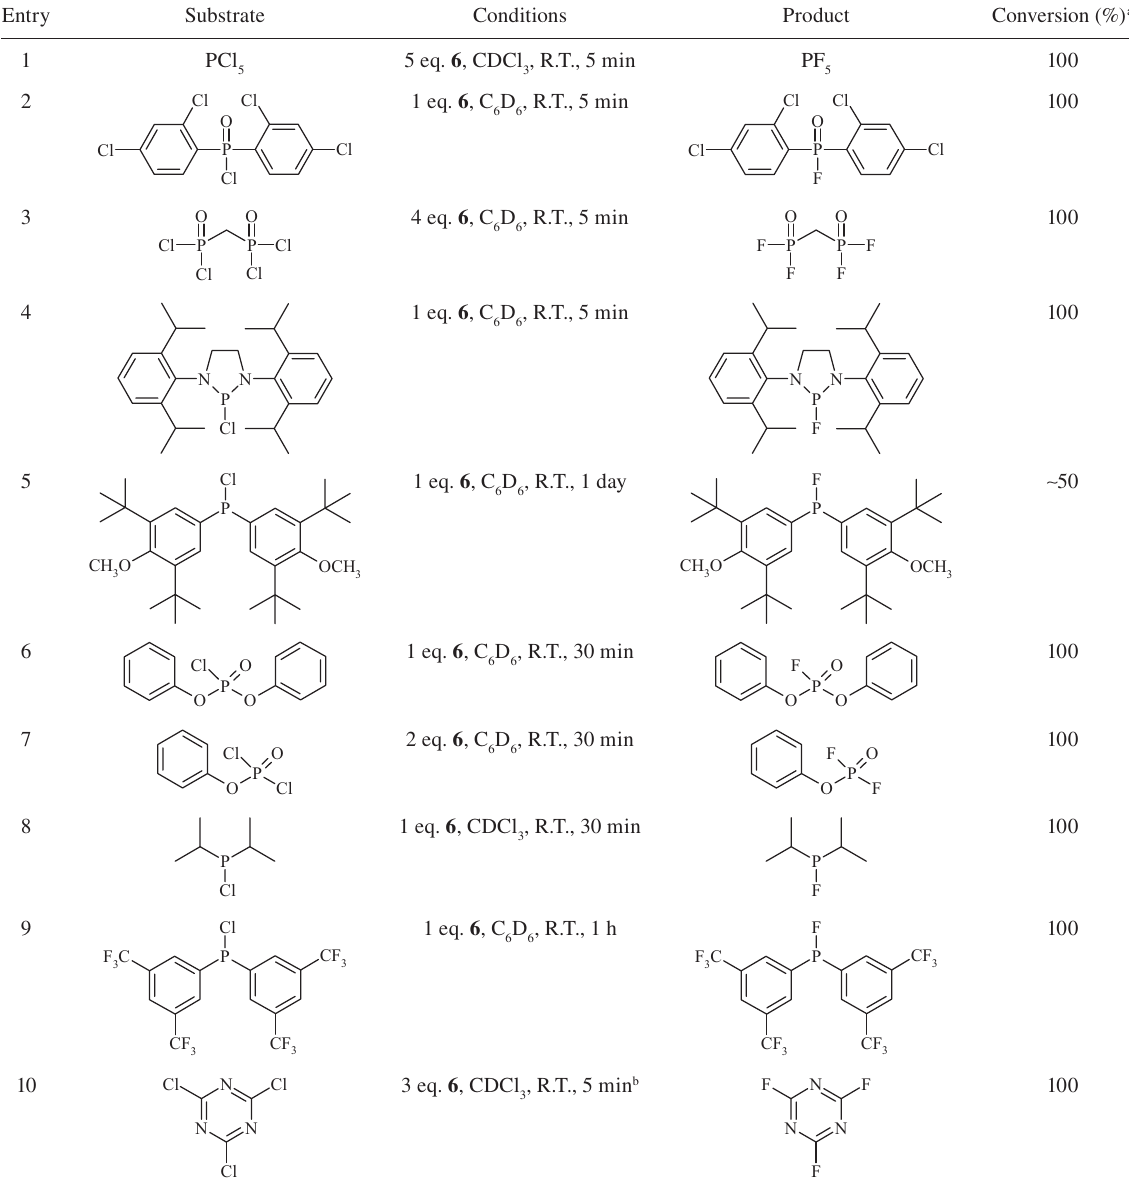
Table 4 Fluorination experiments of some organochlorophosphines, organochlorophosphates and cyanuric chloride. Entry Substrate